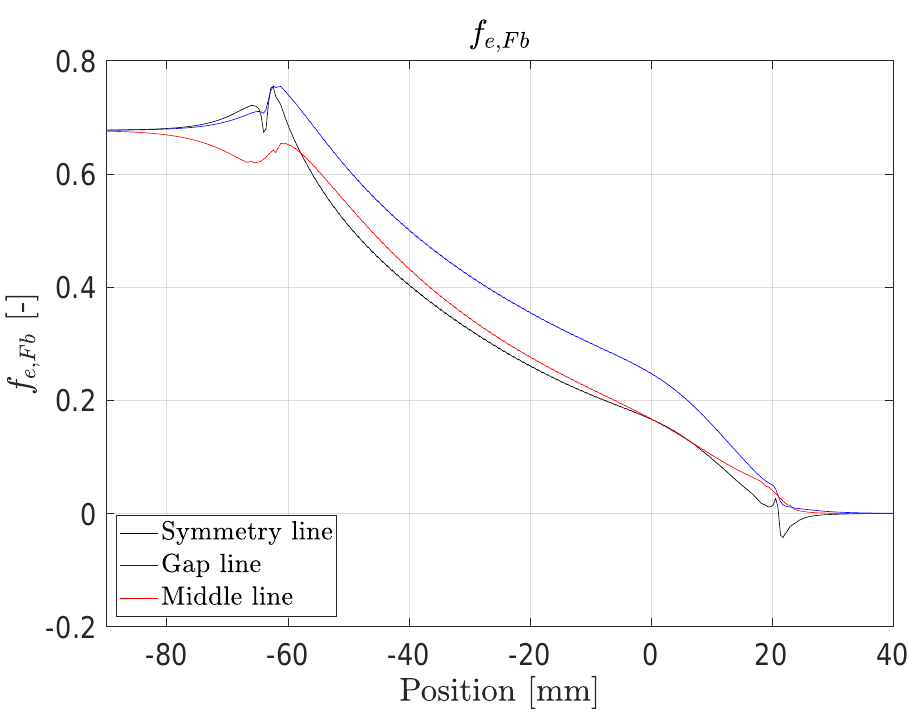
Figure 17. fiber fracture exertion at σ = 1856 MPa along the tendon.